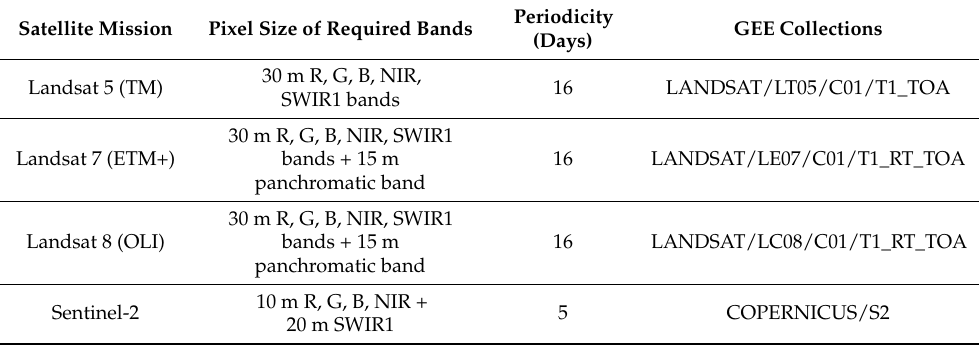
Table 2. Description of satellite datasets on GEE that were accessible with